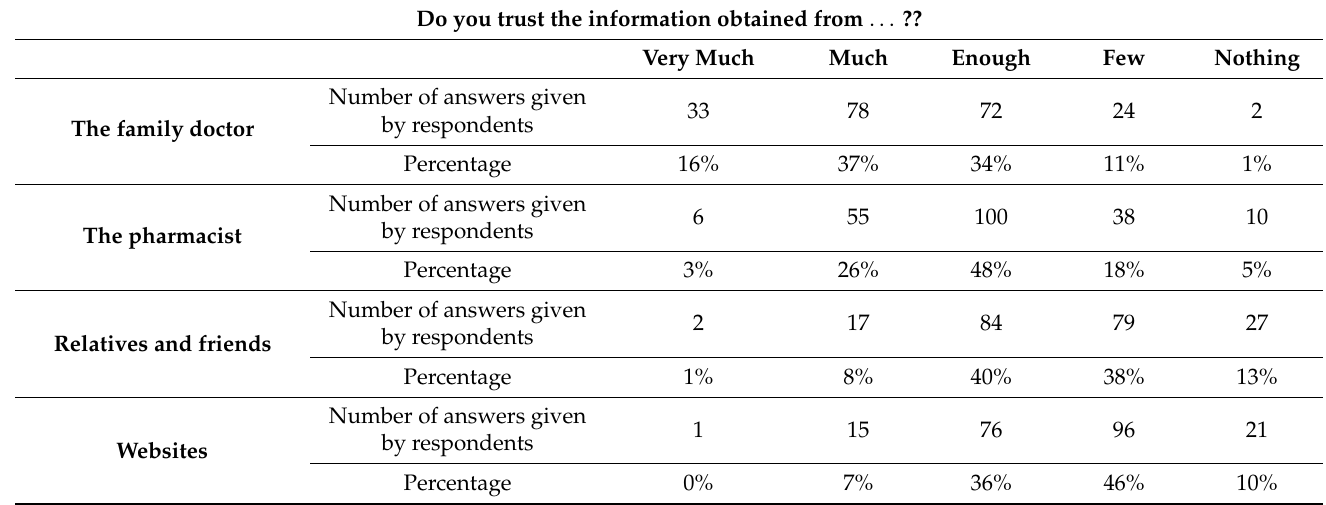
Table 3. Perceived trust in actors/sources used to obtain information related to health